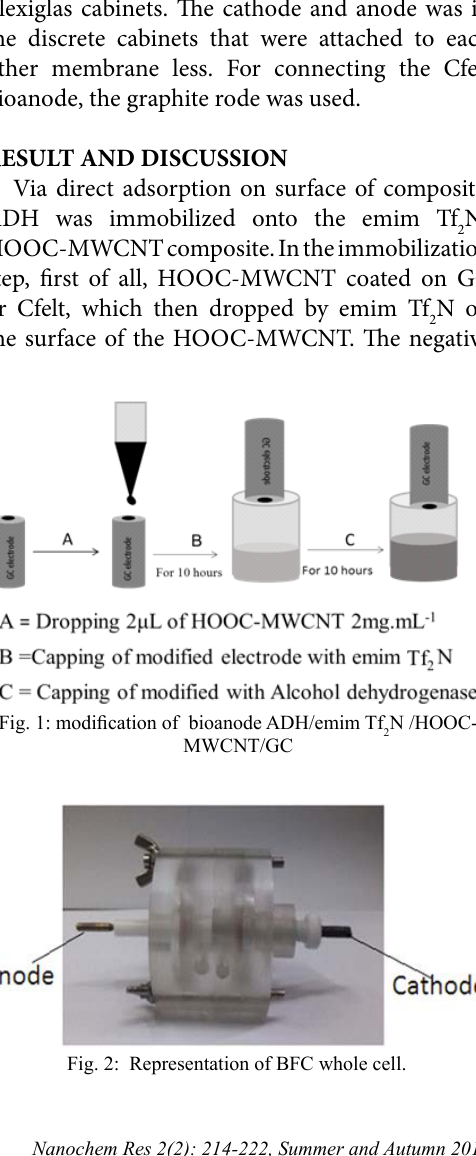
Fig. 2: Representation of BFC whole Fig. 2